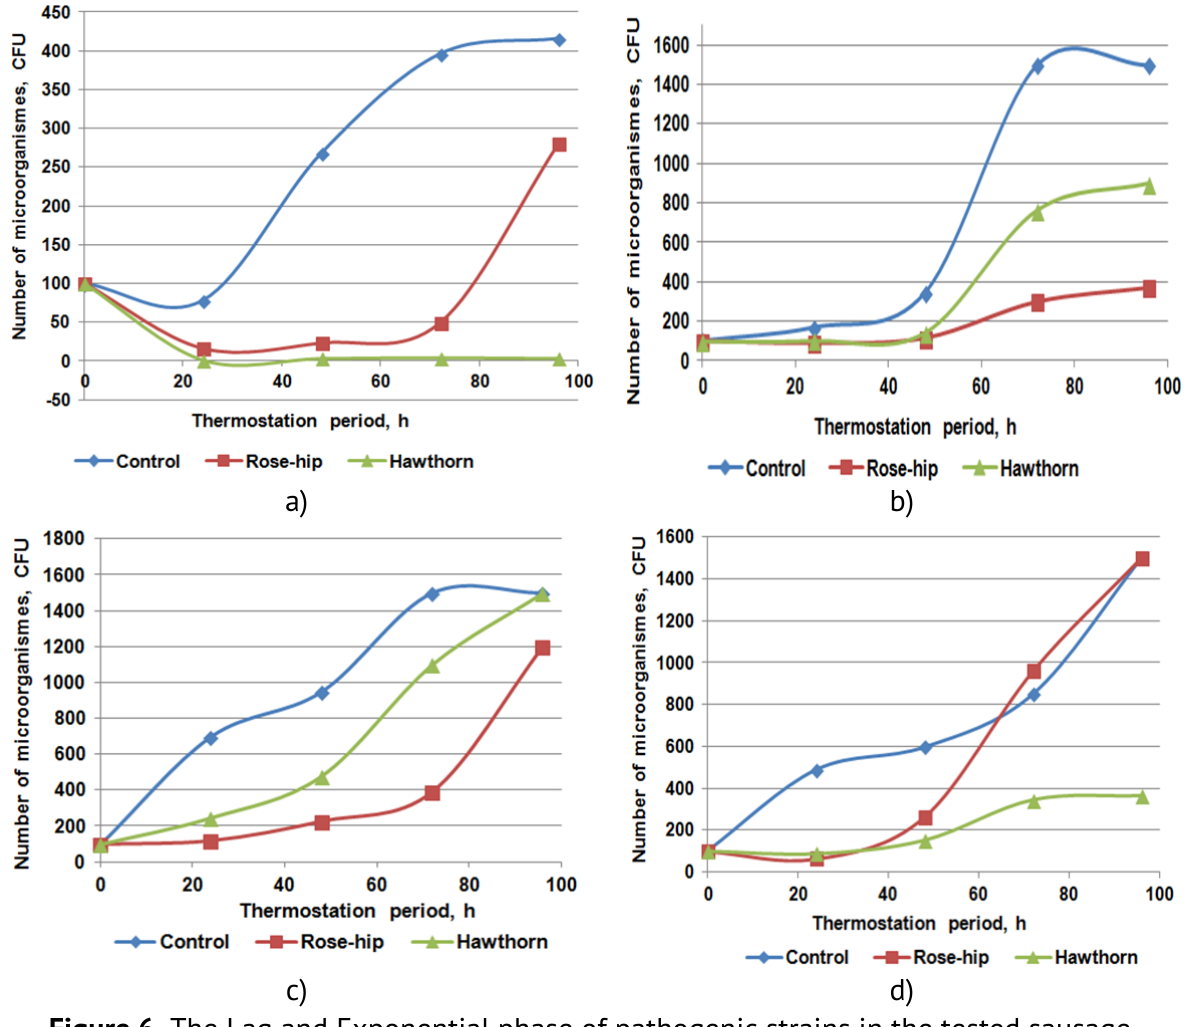
Figure 6. The Lag and Exponential phase of pathogenic strains in the tested sausage samples (testing period of 96 h): a) S. aureus ATCC 25923; b) Klebsiella pneumoniae ATCC 13883; c) Salmonella Abony ATCC 6017; d) E. coli ATCC